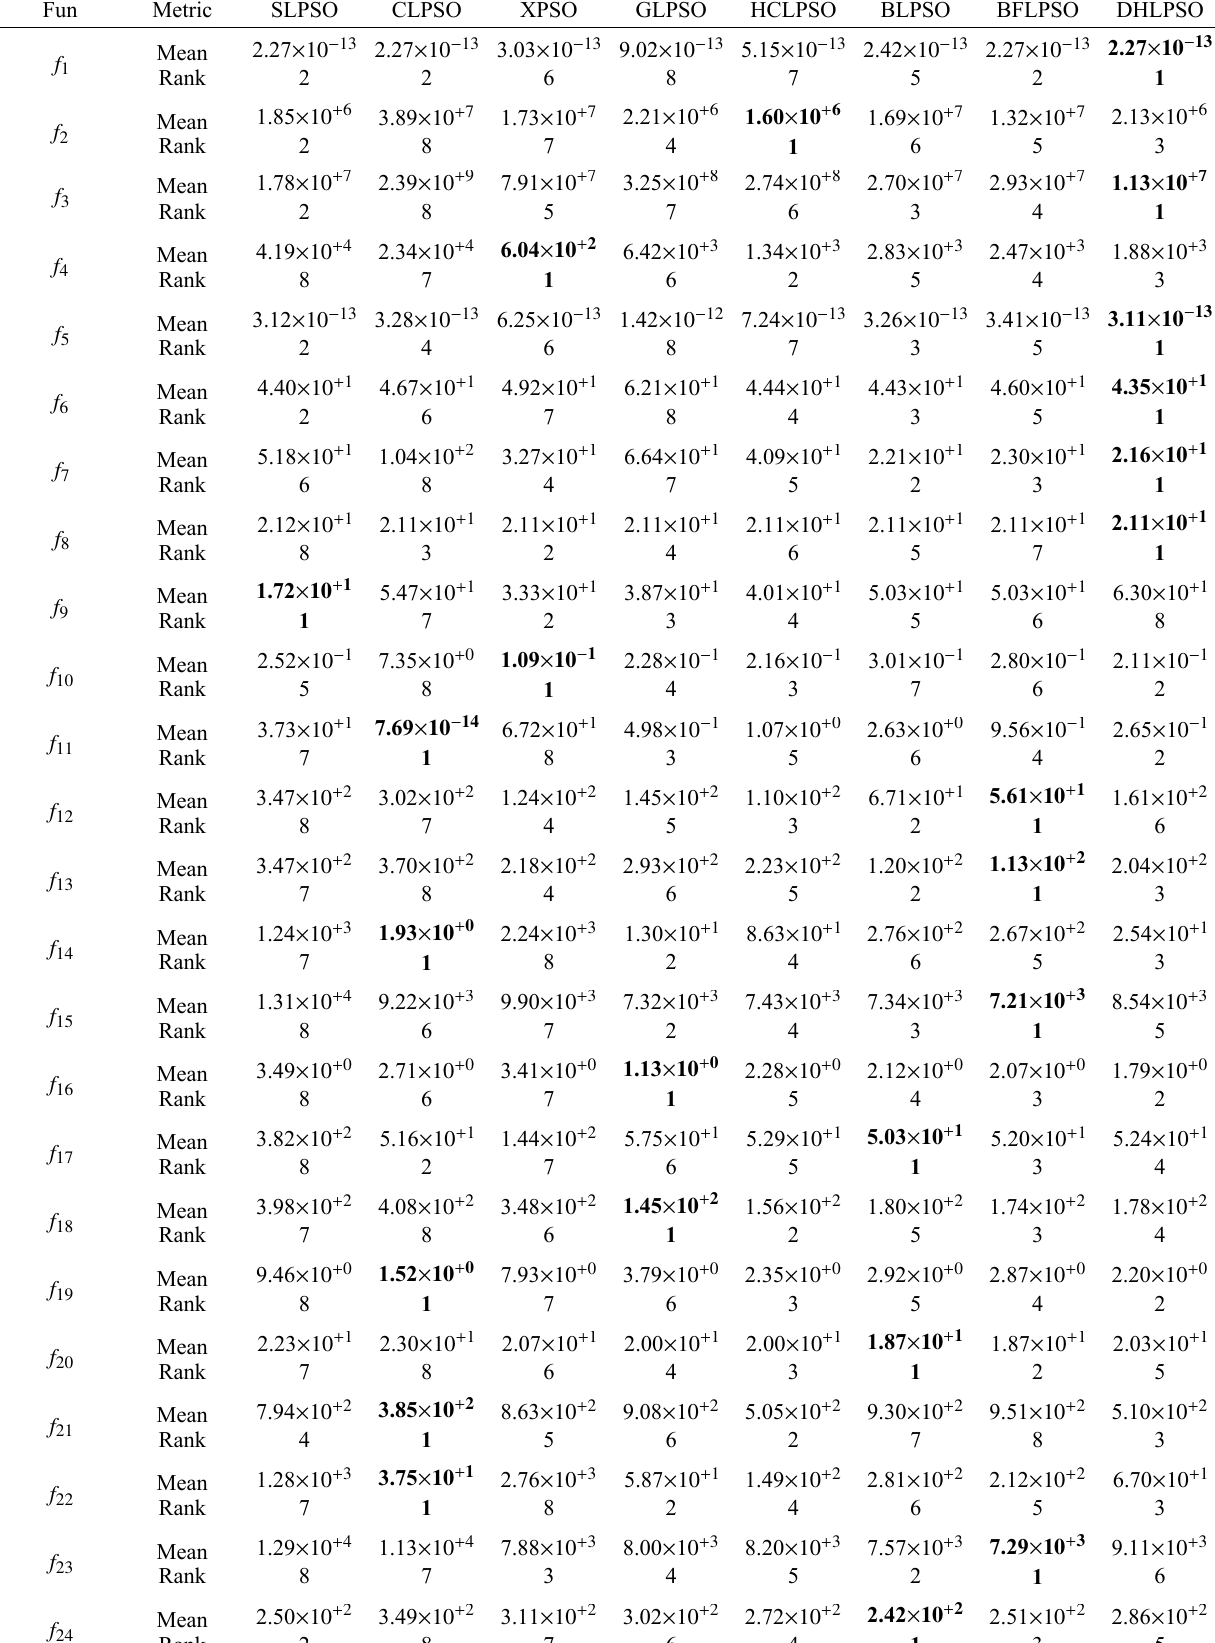
Table A4 Comparison results ( D =